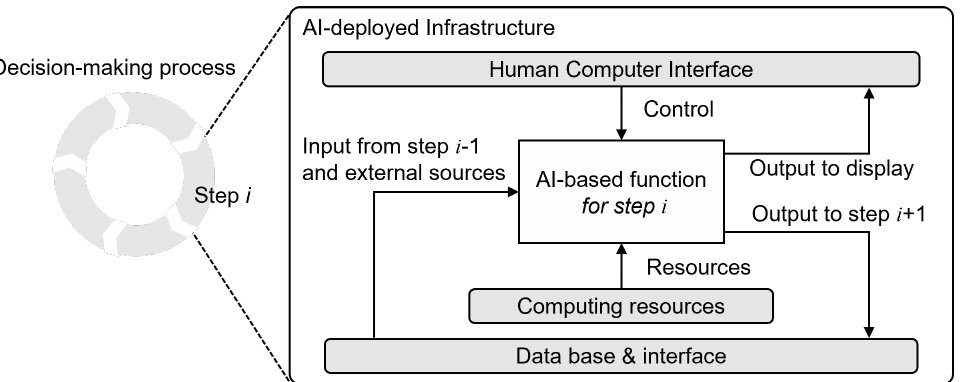
Figure 7. A solution architecture design with AI-based